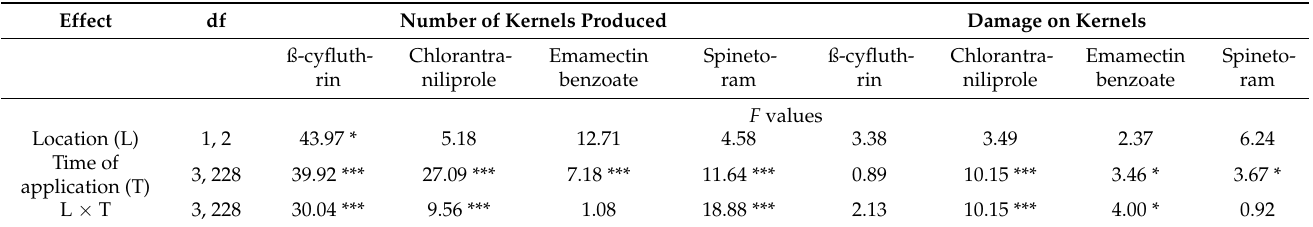
Table 2. Combined analysis of variance for the number of kernels produced and percentages of damage of corn earworm ( Helicoverpa zea (Boddie) (Lepidoptera: Noctuidae)) and fall armyworm ( Spodoptera frugiperda (J. E. Smith) (Lepidoptera: Noctuidae)) per each insecticide in sweet corn ( Zea